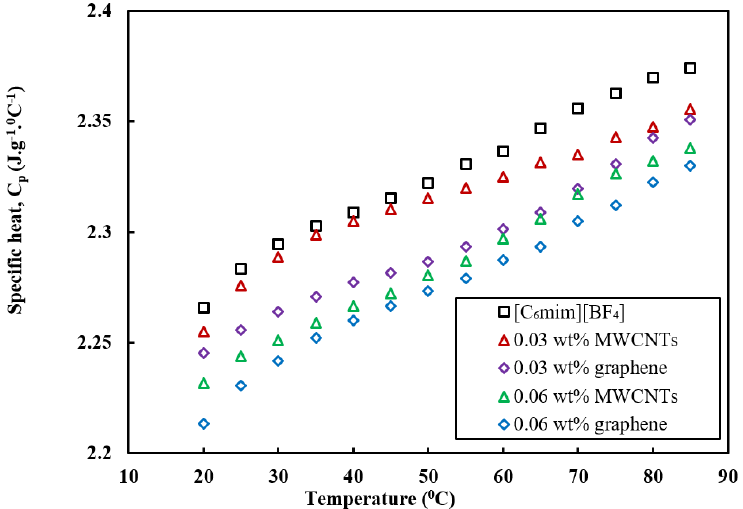
Figure 7. [C 6 mim][BF 4 ] and MWCNT, GE-dispersed IL [53] as a function of temperature. Reproduced with permission from F Wang, Nanoscale research letters; published by [Springer], 2012 .